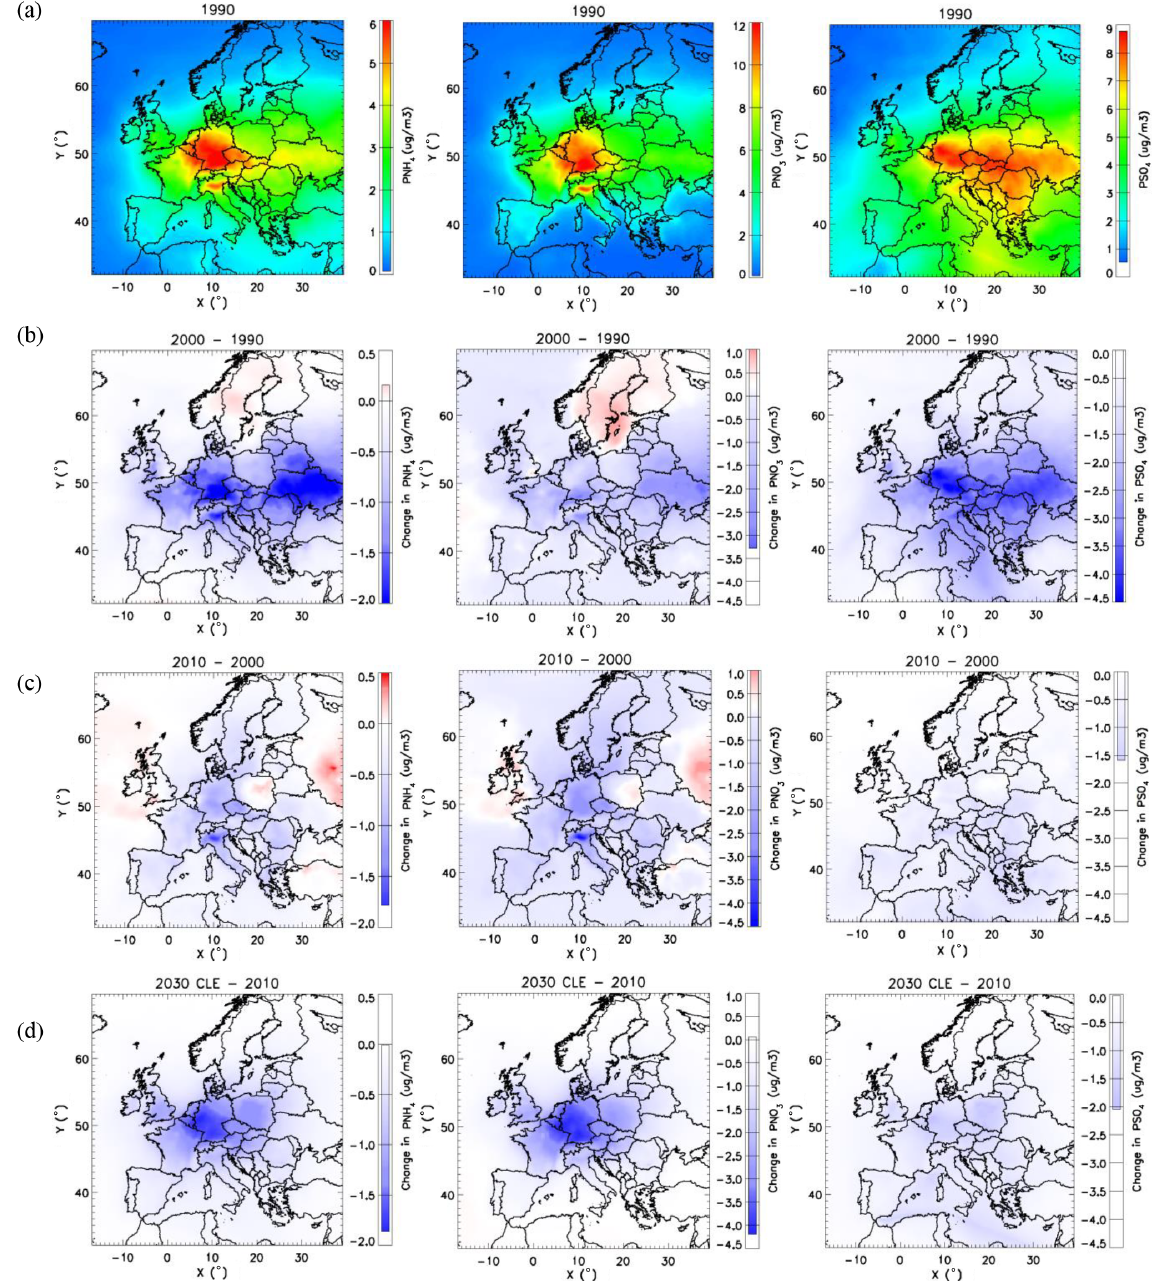
Figure 3. Ammonium (left), particulate nitrate (middle) and sulfate (right): (a) annual average concentrations (µgm − 3 ) in 1990; changes (µgm − 3 ) between (b) 1990–2000, (c) 2000–2010 and (d)